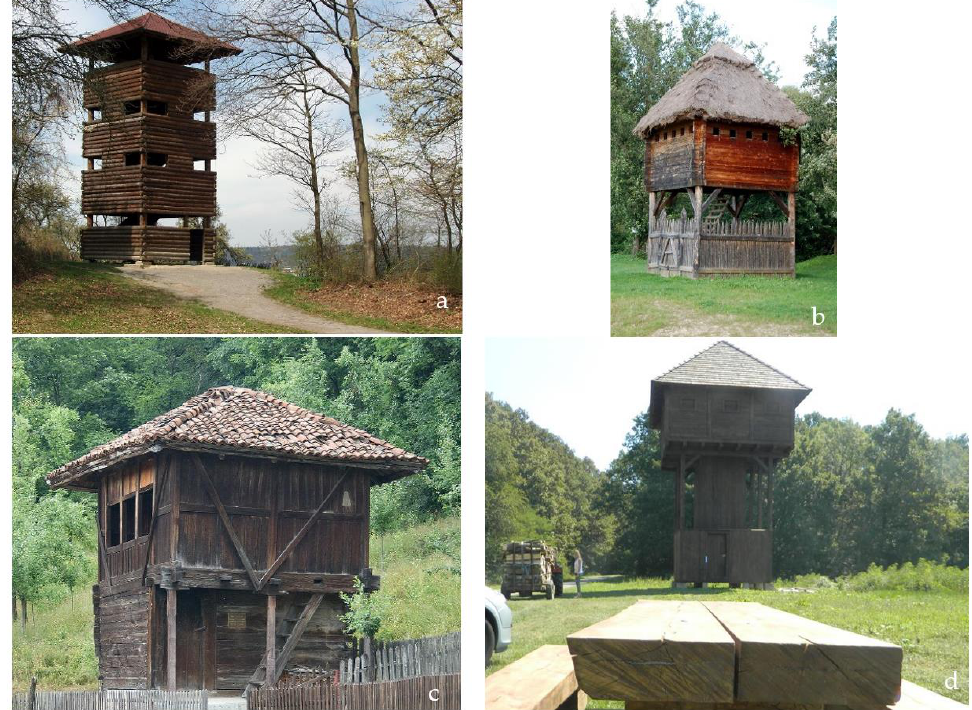
Figure 4. Some 1:1 reconstructions: ( a ) Niefern-Oschelbron, Germany; ( b ) Burgau/Lafnitz, Austria; ( c ) Šumadija, Serbia; ( d ) Dragalić, Croatia.